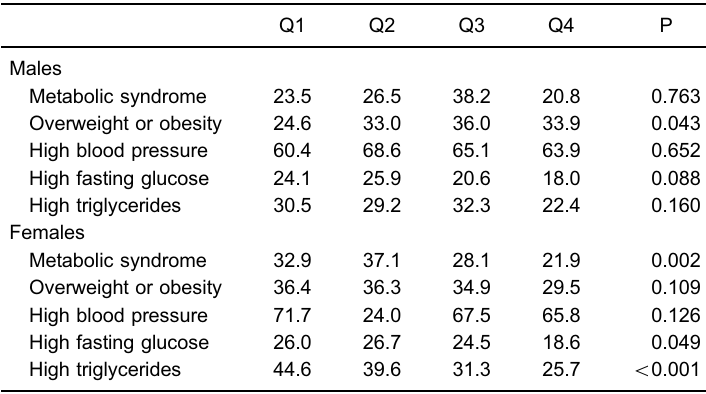
Table 3. Prevalence of metabolic syndrome and its components per quartile of total bilirubin (%).